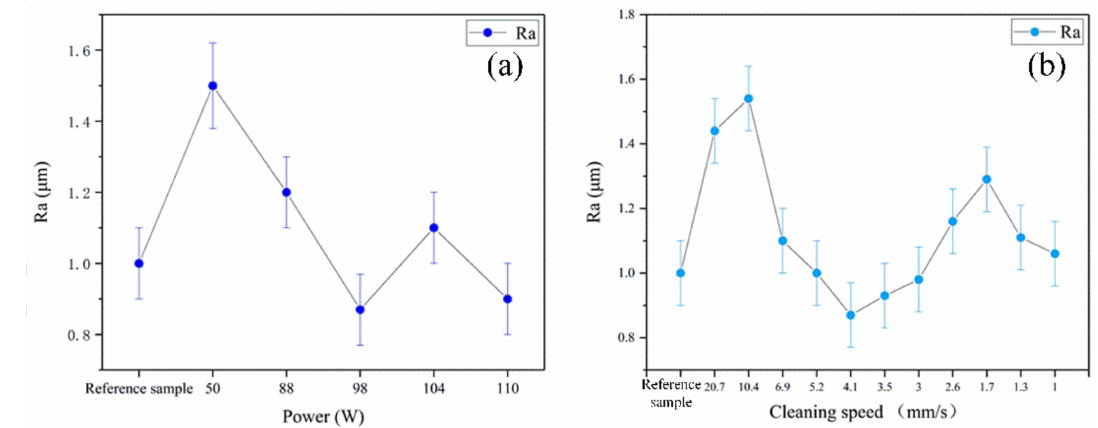
Figure 3. Surface roughness of aluminum alloy after laser cleaning: ( a ) Under di ff erent powers; ( b ) at di ff erent speeds.